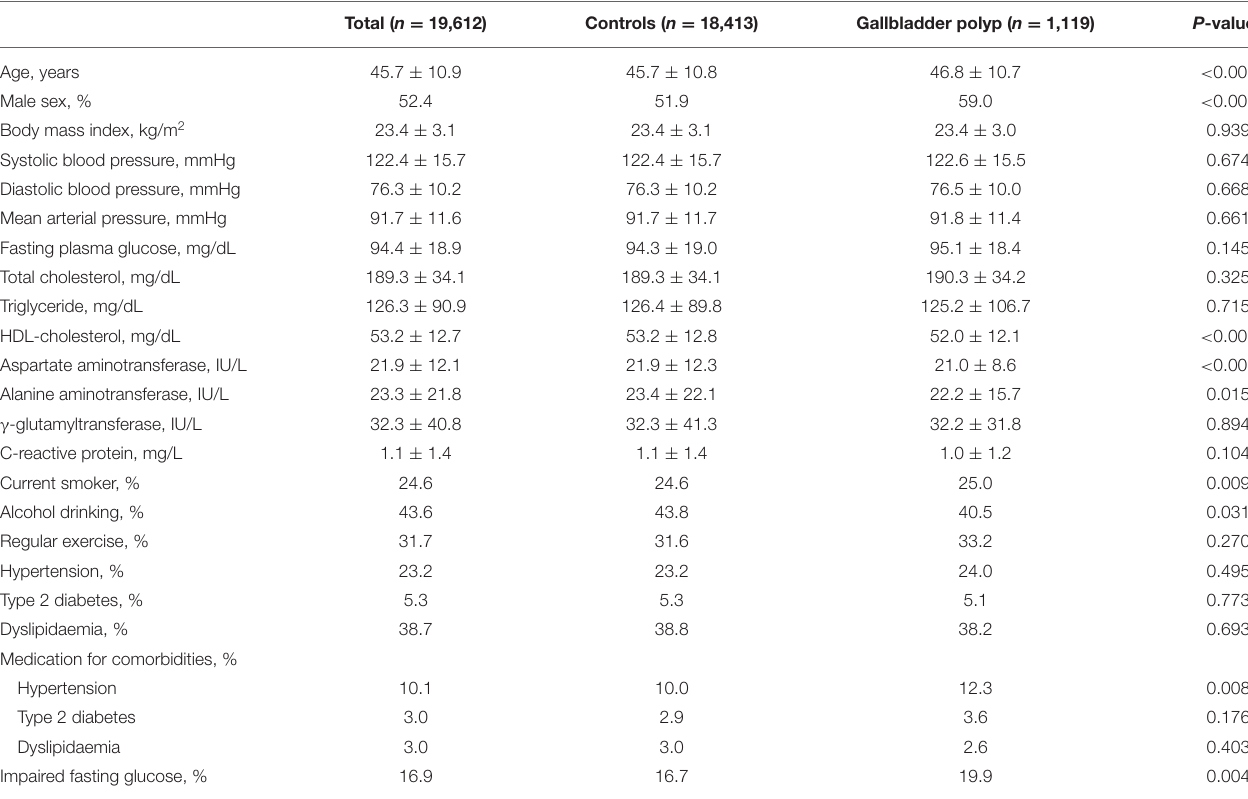
TABLE 1 | Clinical and biochemical characteristics of the study population.